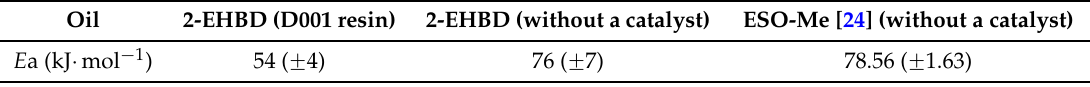
Table 2. E a and rate equation of different ring-opening reactions.